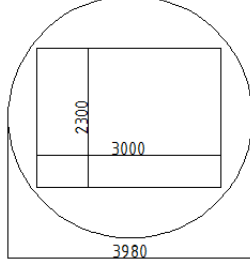
Figure 2. A round pipe